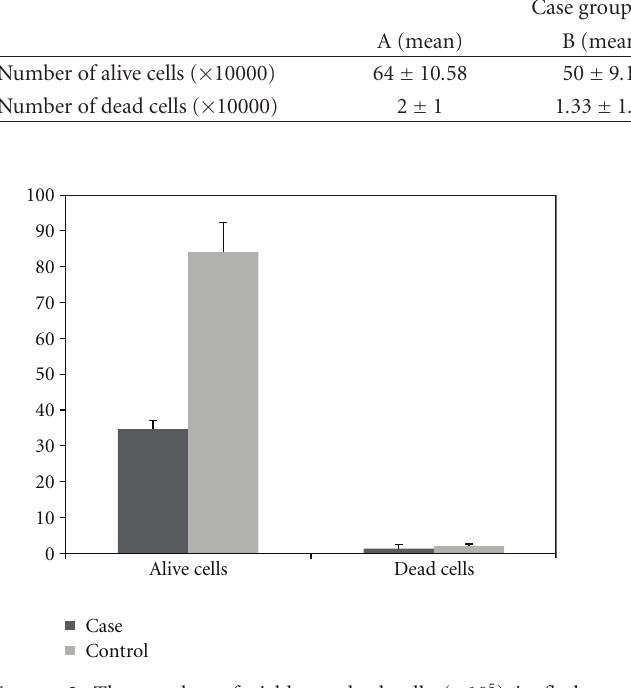
Figure 3: The number of viable or dead cells ( × 10 5 ) in flasks of BHK fibroblast cell 48 h after treatment with 100 hydatid cyst protoscolices compared to control cells (mean of triplicate